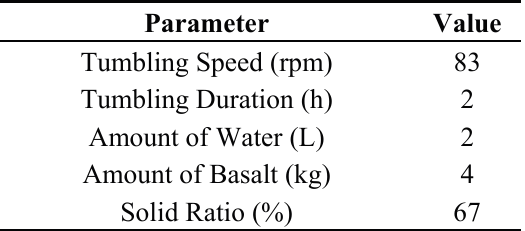
Table 3. Fixed experimental tumbling parameters